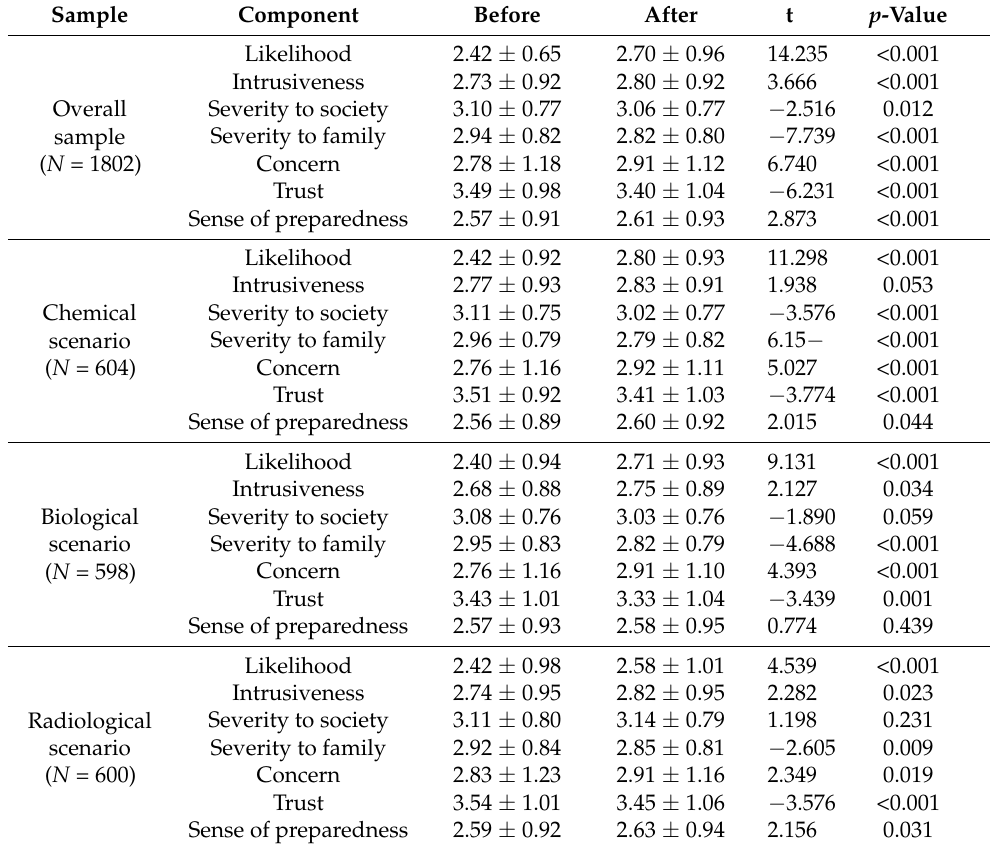
Table 2. Mean scores of non-conventional terrorism threat perception components before and after intervention in all study branches ( N =